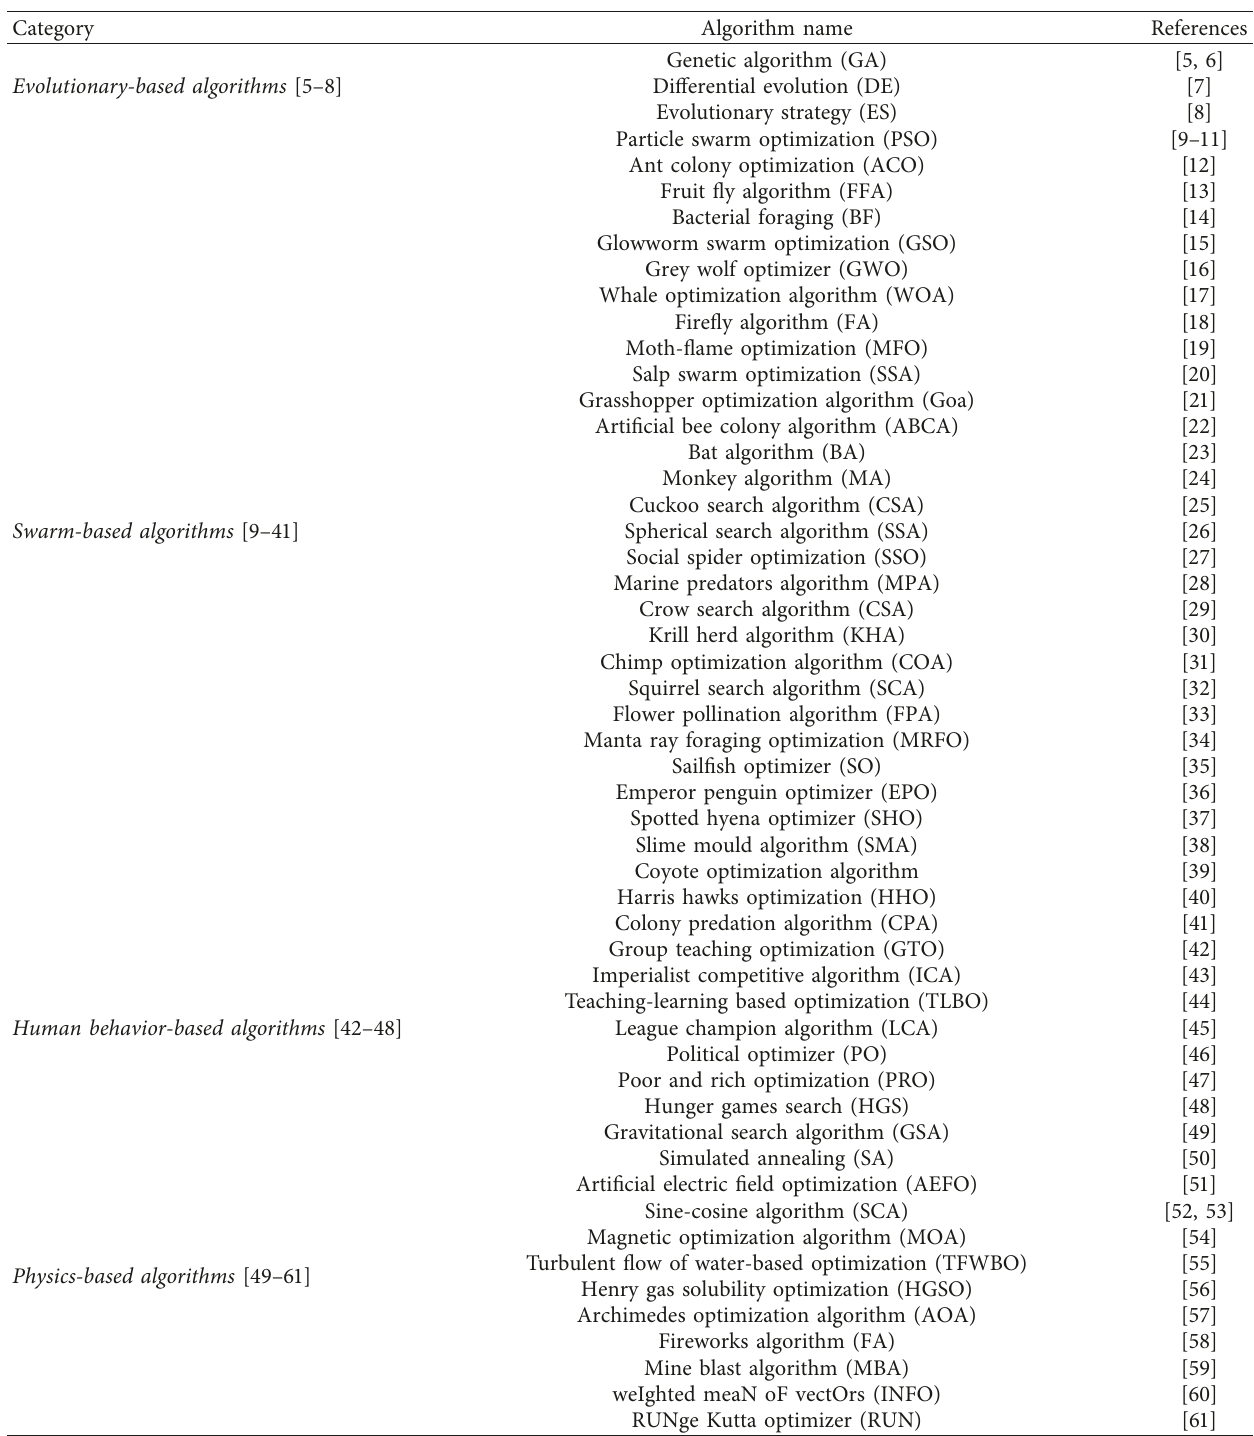
Table 1: Meta-heuristic algorithms classification